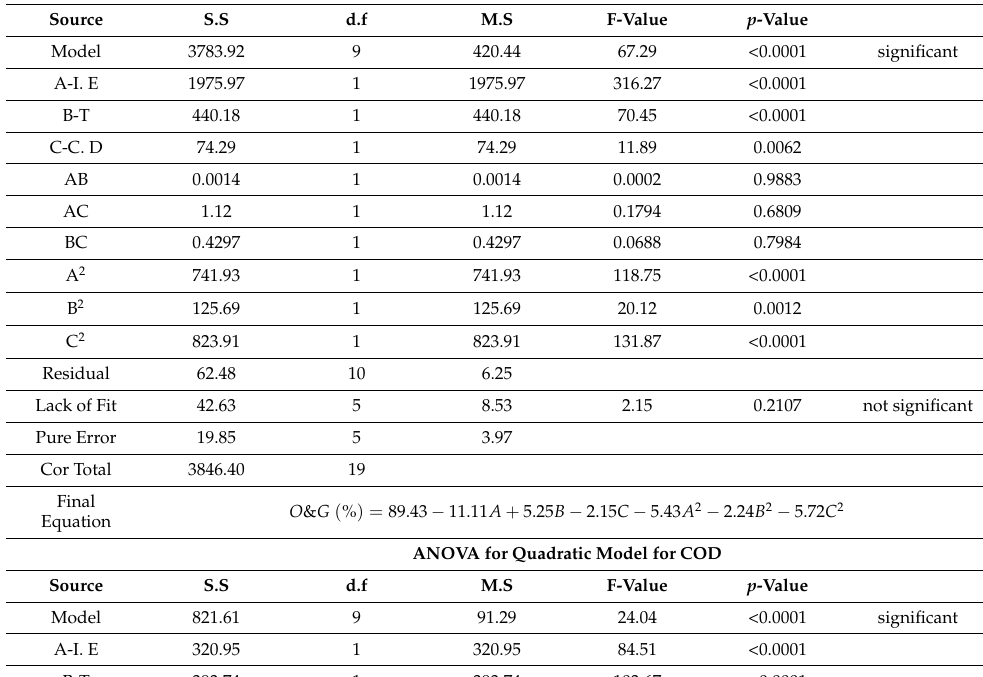
Table 6. Analysis of variance (ANOVA) and regression model validation on O&G (%) and COD (%)